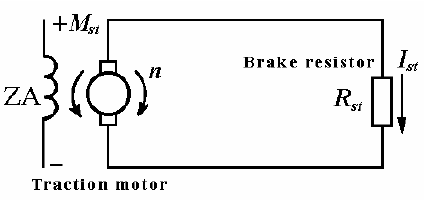
Fig 10. Traction motor operating in rheostatic braking